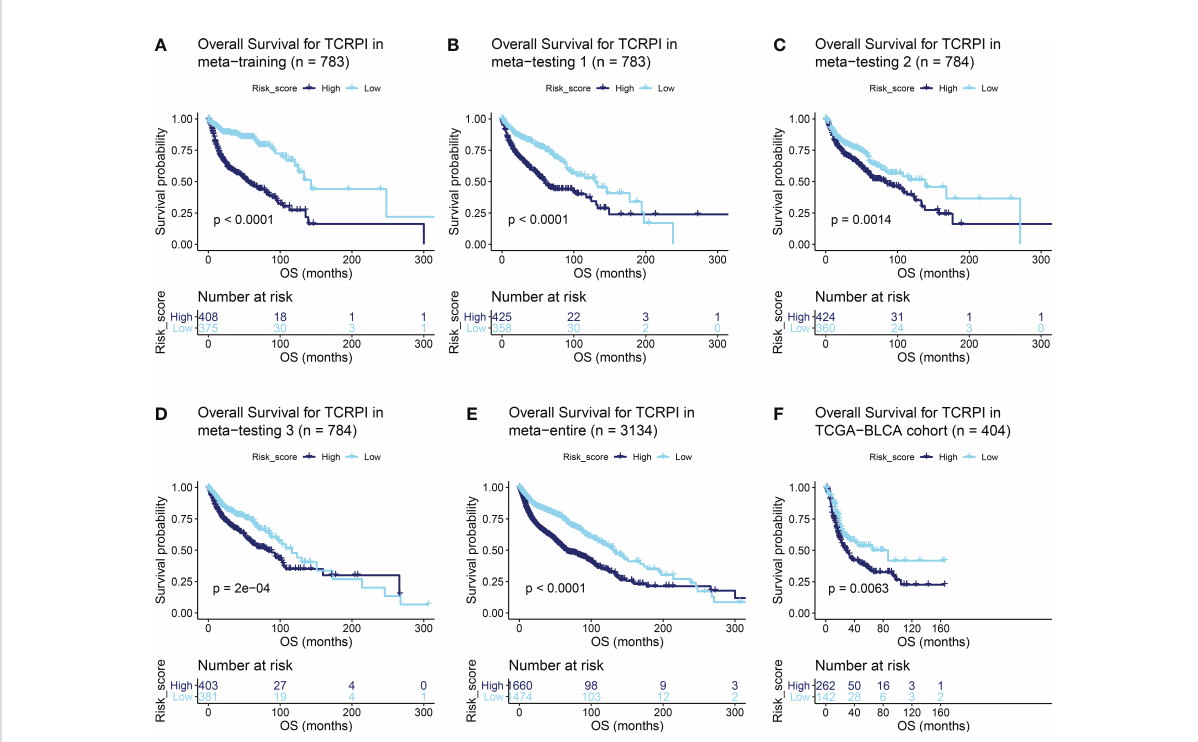
FIGURE 2 Survival difference across the TCRPI-high risk and TCRPI-low risk groups. (A) Overall survival curve for TCPRI in the meta-training cohort. (B) Overall survival curve for TCPRI in the meta-testing cohort 1. (C) Overall survival curve for TCPRI in the meta-testing cohort 2. (D) Overall survival curve for TCPRI in the meta-testing cohort 3. (E) Overall survival curve for TCPRI in the meta-entire cohort. (F) Overall survival curve for TCPRI in the TCGA-BLCA